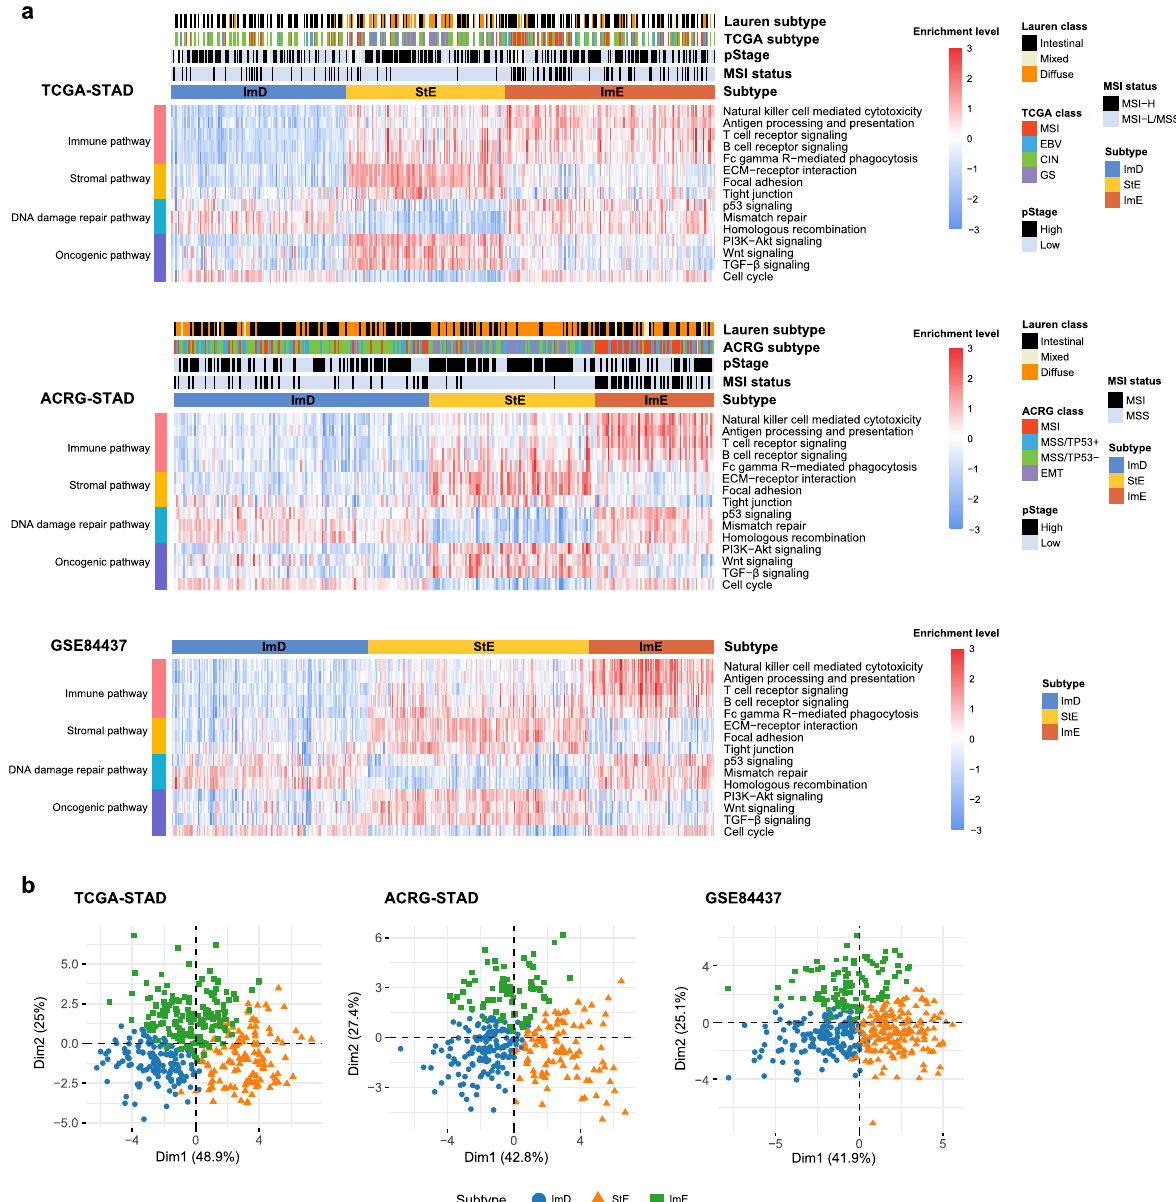
Fig. 1 Identi fi cation of subtypes of gastric cancer based on pathway clustering. a Consensus clustering of gastric cancer (GC) identi fi es three subtypes (ImD, StE, and ImE) based on the enrichment levels of 15 pathways in 3 different datasets (TCGA-STAD, ACRG-STAD, and GSE84437). The enrichment levels of the pathways were evaluated by ssGSEA 26 of all genes involved in them. The 15 pathways are associated with immune, DNA damage repair, oncogenic, and stromal signatures. b PCA con fi rms that GCs can be clearly separated into three subgroups based on the ssGSEA scores of the pathways. ImD immunity-deprived, StE stroma-enriched, ImE immunity-enriched, MSI microsatellite instable, MSS microsatellite stable, MSI-H high microsatellite instability, MSI-L low microsatellite instability, EMT epithelial – mesenchymal transition (These also apply to the following fi